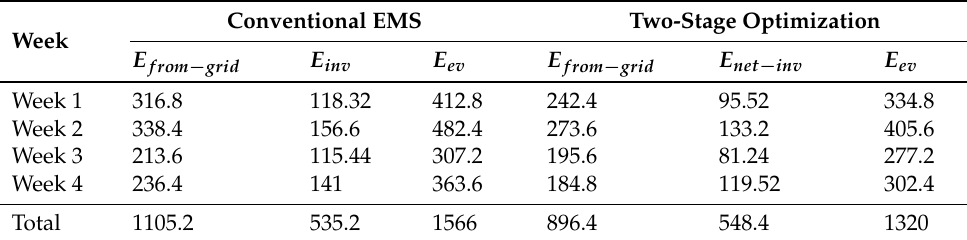
Table 2. Total energy (MWh) values for the grid, inverter, and power consumed by the EVs.